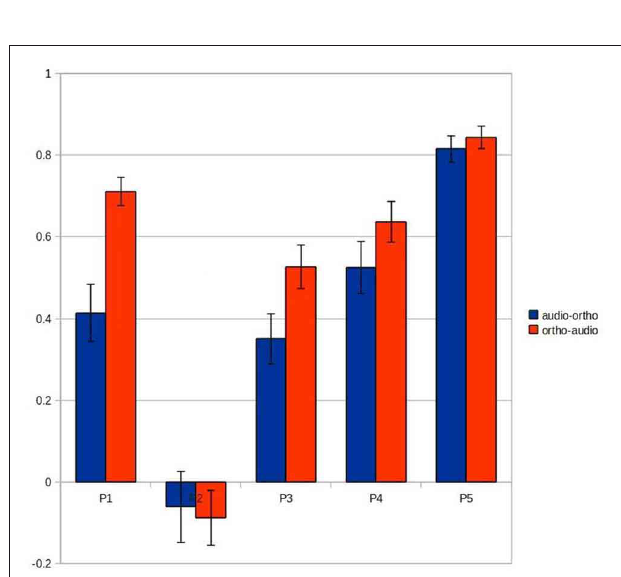
FIGURE 7 | Correlations between the vectors of the mammal/tool difference time-courses recorded at the voxels selected for the audio-ortho (blue) and ortho-audio predictions (red). Each error bar represents Standard